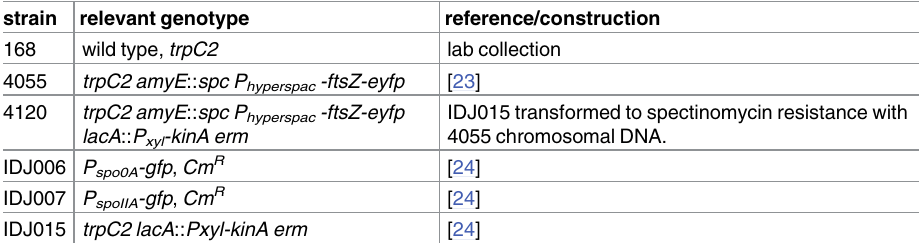
Table 1. B . subtilis strains used in this